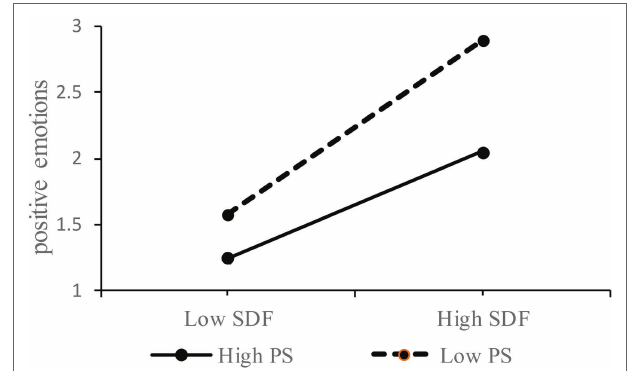
FIGURE 2 | The moderating effect of psychological empowerment on the influence of supervisor developmental feedback on positive emotions. SDF represents supervisor developmental feedback; PS represents psychological